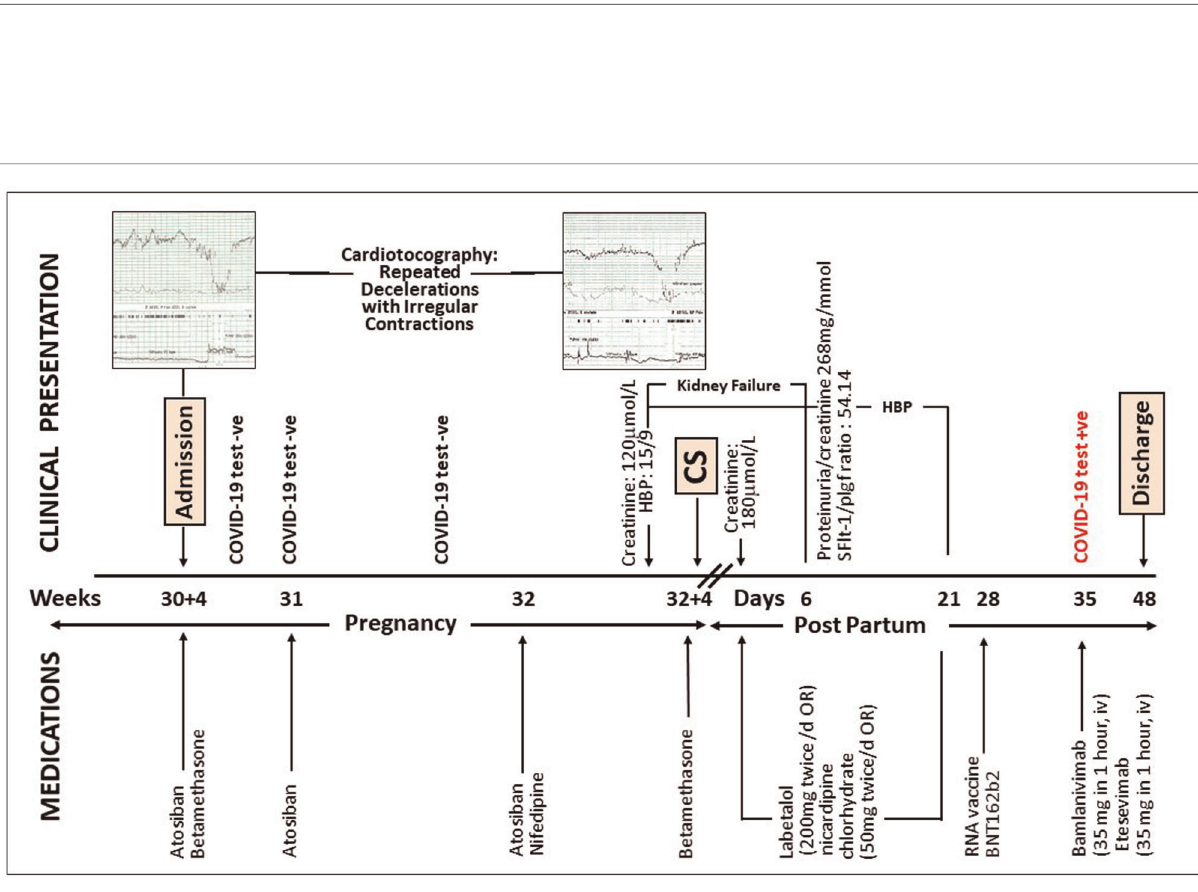
Frontiers in Surgery |